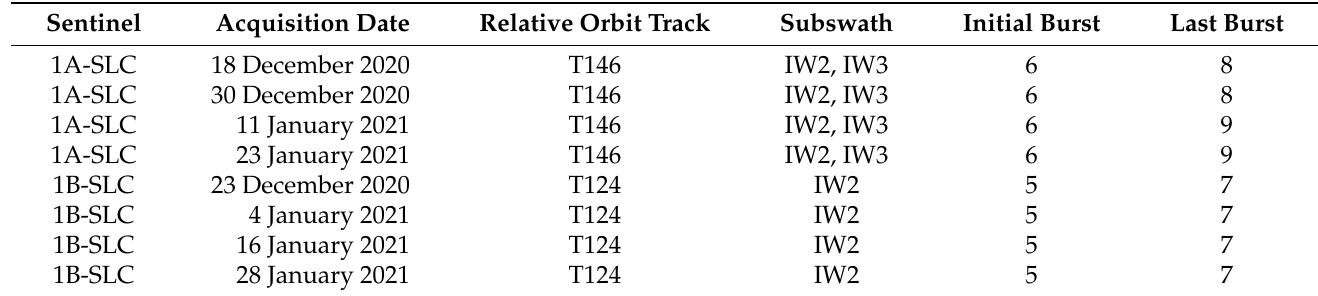
Table 1. Properties of used Sentinel-1 SAR images.